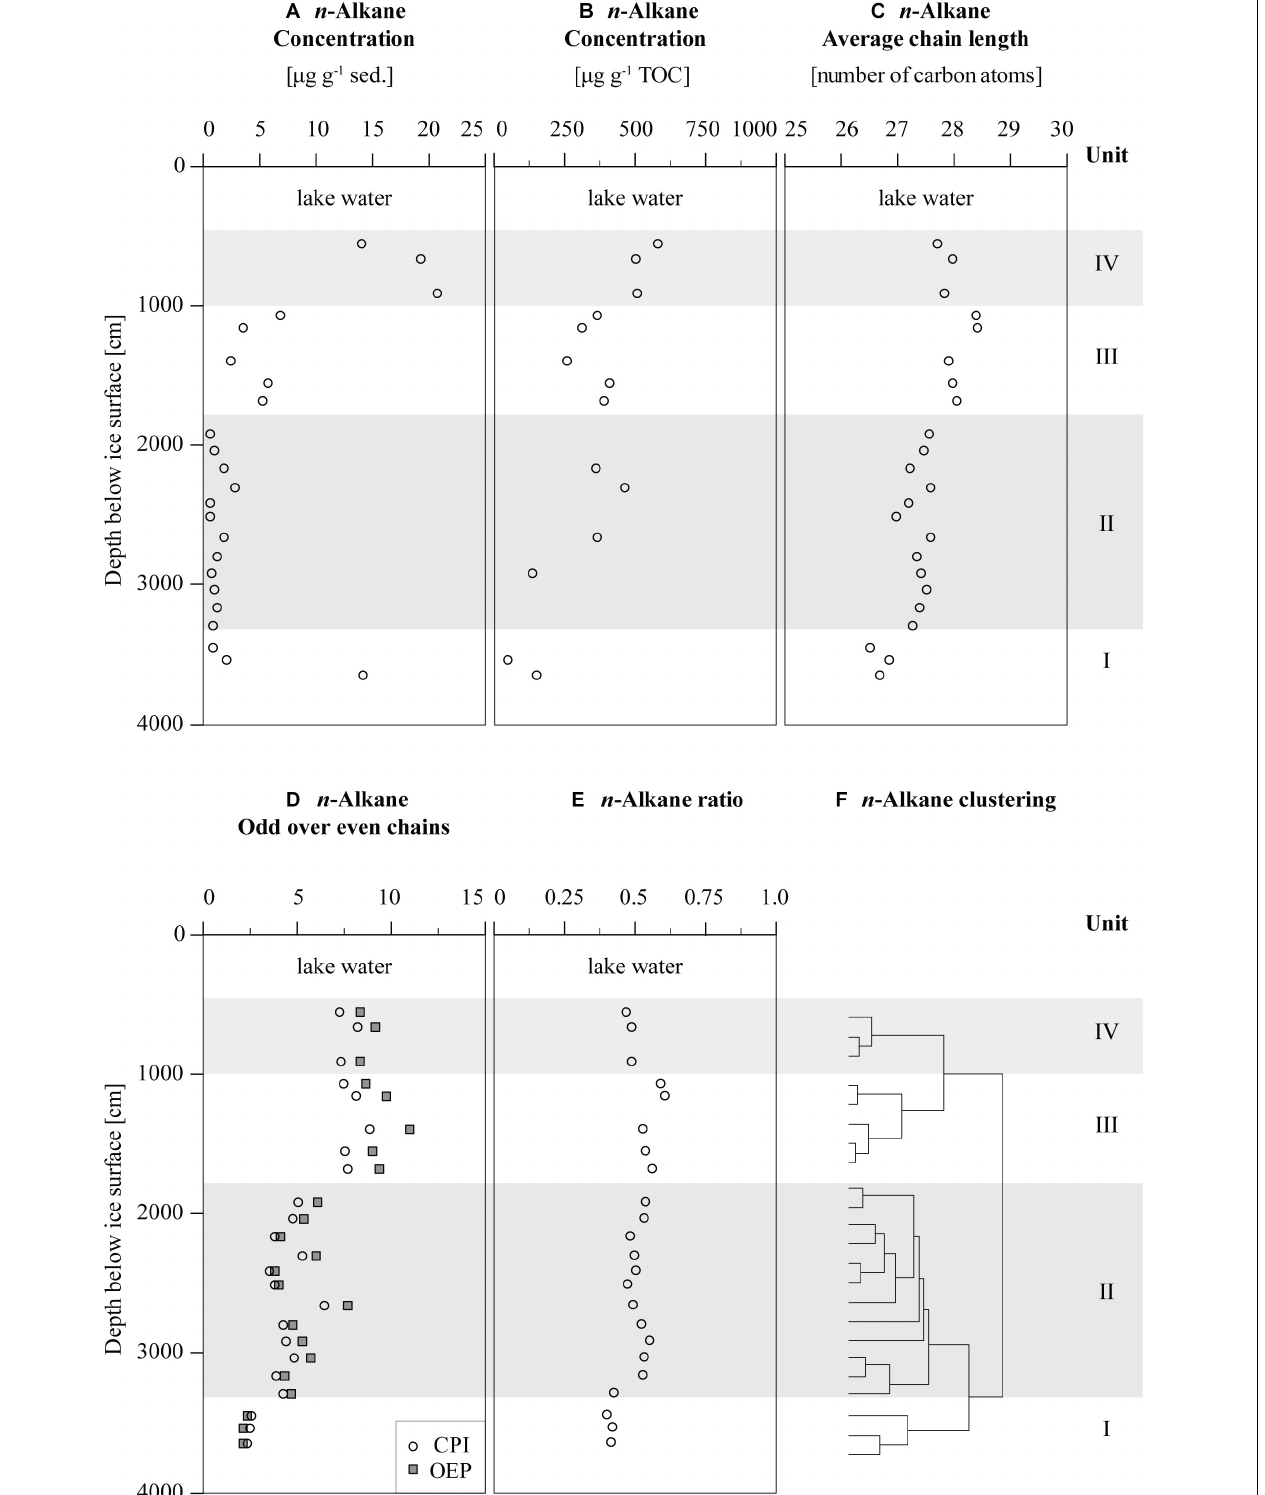
Frontiers in Environmental Science |